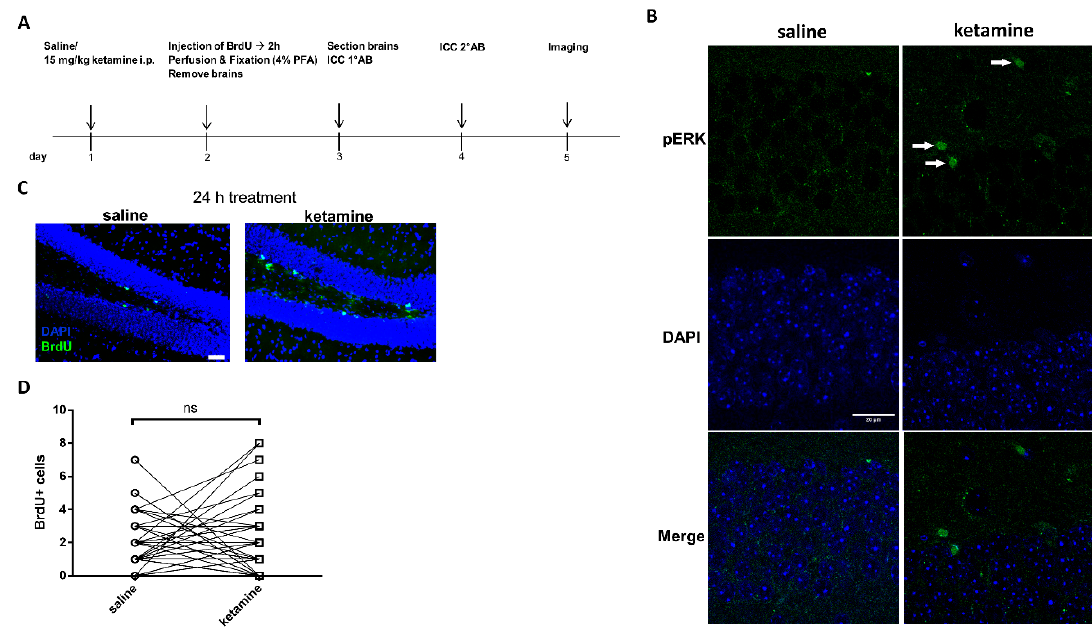
Figure 8. Ketamine increased extracellular signal-regulated protein kinases 1 and 2 (ERK1/2) phosphorylation in mice 24 h after administration ( A ) Experimental timeline: male C67BL/6 mice were injected intraperitoneal (i.p.) with 15 mg/kg ketamine or 0.9% saline. 24 h after injection, mice were injected with 200 mg/kg BrdU and, 2 h later, anesthetized and perfused with 4% paraformaldehyde PFA) and prepared for immunohistochemistry. ( B ) Representative images showing that mice display enhanced ERK1/2 phosphorylation 24 h after acute ketamine treatment, scale = 20 µm. ( C ) Representative images of BrdU staining 24 h after treatment, scale = 50 µm. ( D ) BrdU+ cells in hippocampal sections (40 µm) quantified as the absolute number of BrdU+ cells in each section (four mice for each condition and 12 sections per mouse; One-way ANOVA, posthoc t-test).